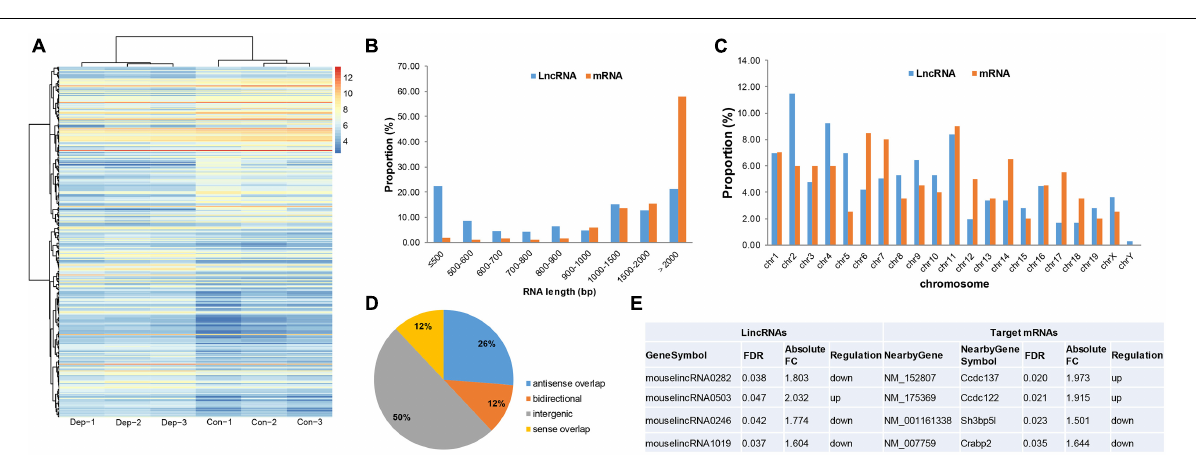
FIGURE 3 | Identification and functional analysis of differentially expressed lncRNAs (DELs) in gut microbiota-dysbiosis mice. (A) Hierarchical clustering of DELs. (B) Comparison of RNA length for DELs versus DEGs. (C) Comparison of chromosome distribution for DELs versus DEGs. (D) Classification of DELs based on the relationship between lncRNAs and their associated protein-coding genes. (E) Intergenic lncRNAs and their cis -regulated nearby genes. FDR, false discovery rate; FC, fold